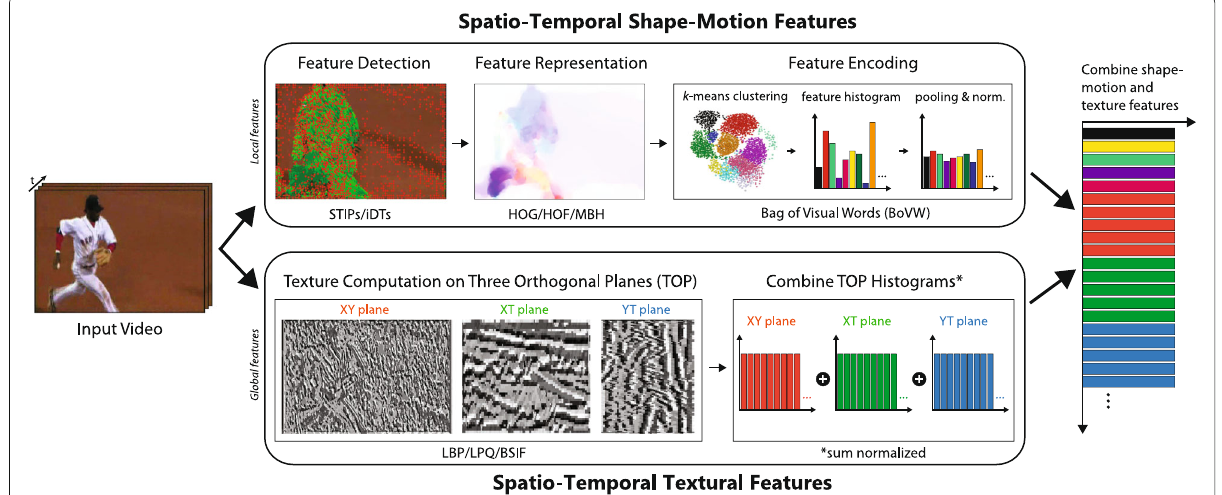
Fig. 2 Proposed joint feature utilization framework for human action